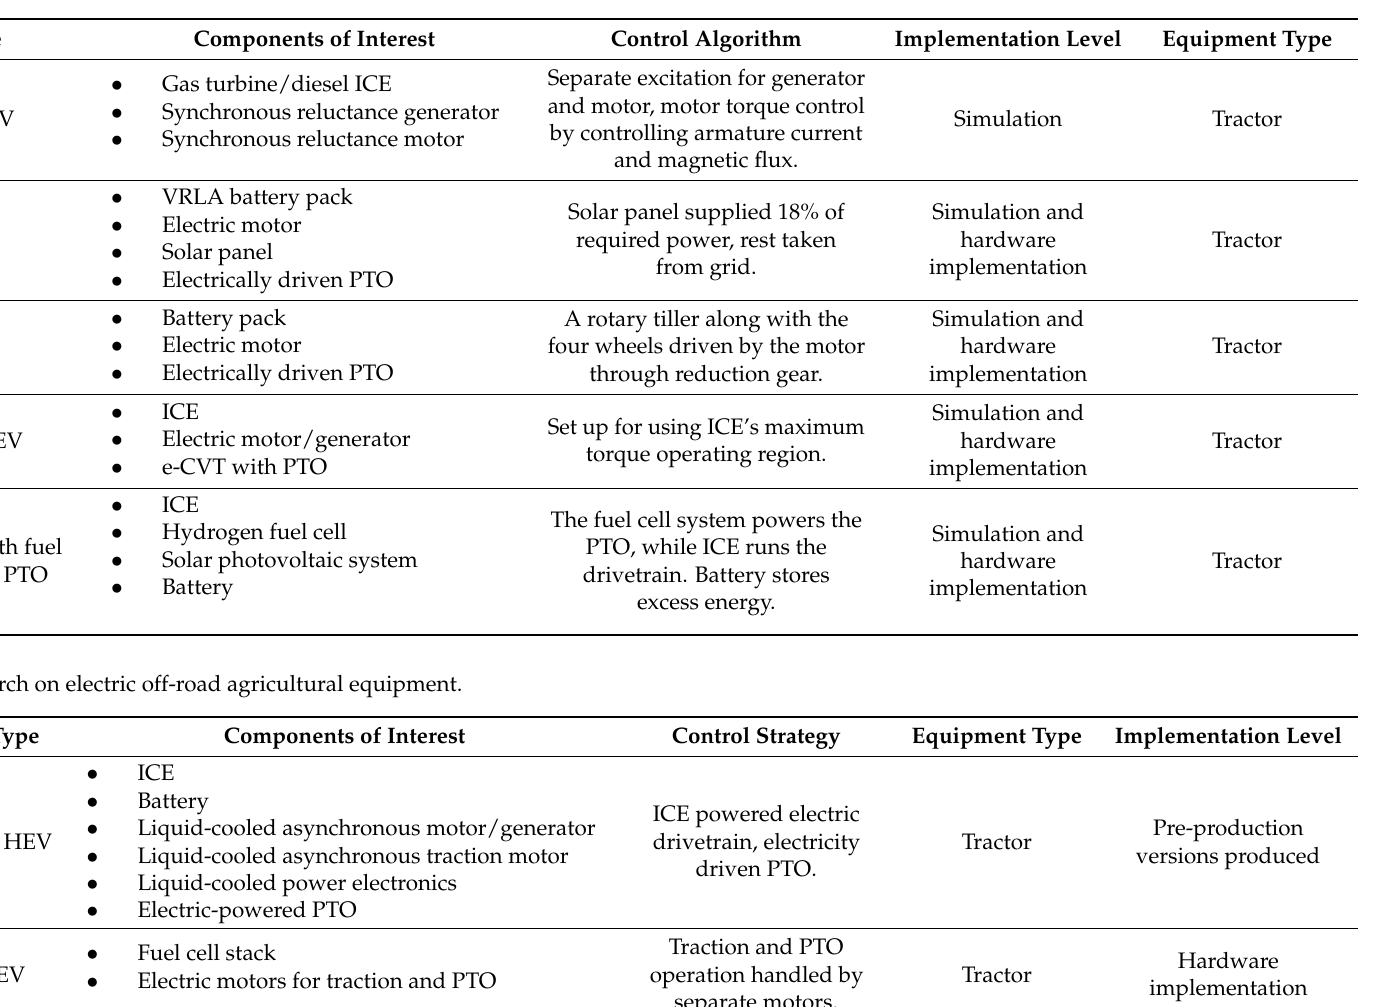
Table 5. Academic literature on electric off-road agricultural equipment.